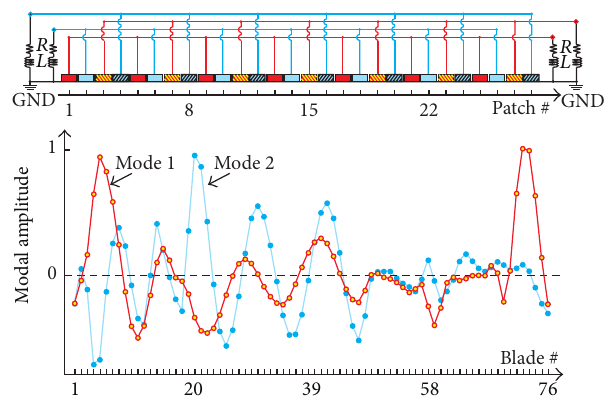
Figure 15: Numbering of the 28 PZT patches and numbering of the blades along the circumference of the drum. The upper figure indicates the electrical connections of the PZT patches in 4 independent loops for the parallel shunt; the lower figure shows the shape of the targeted modes (1F7).